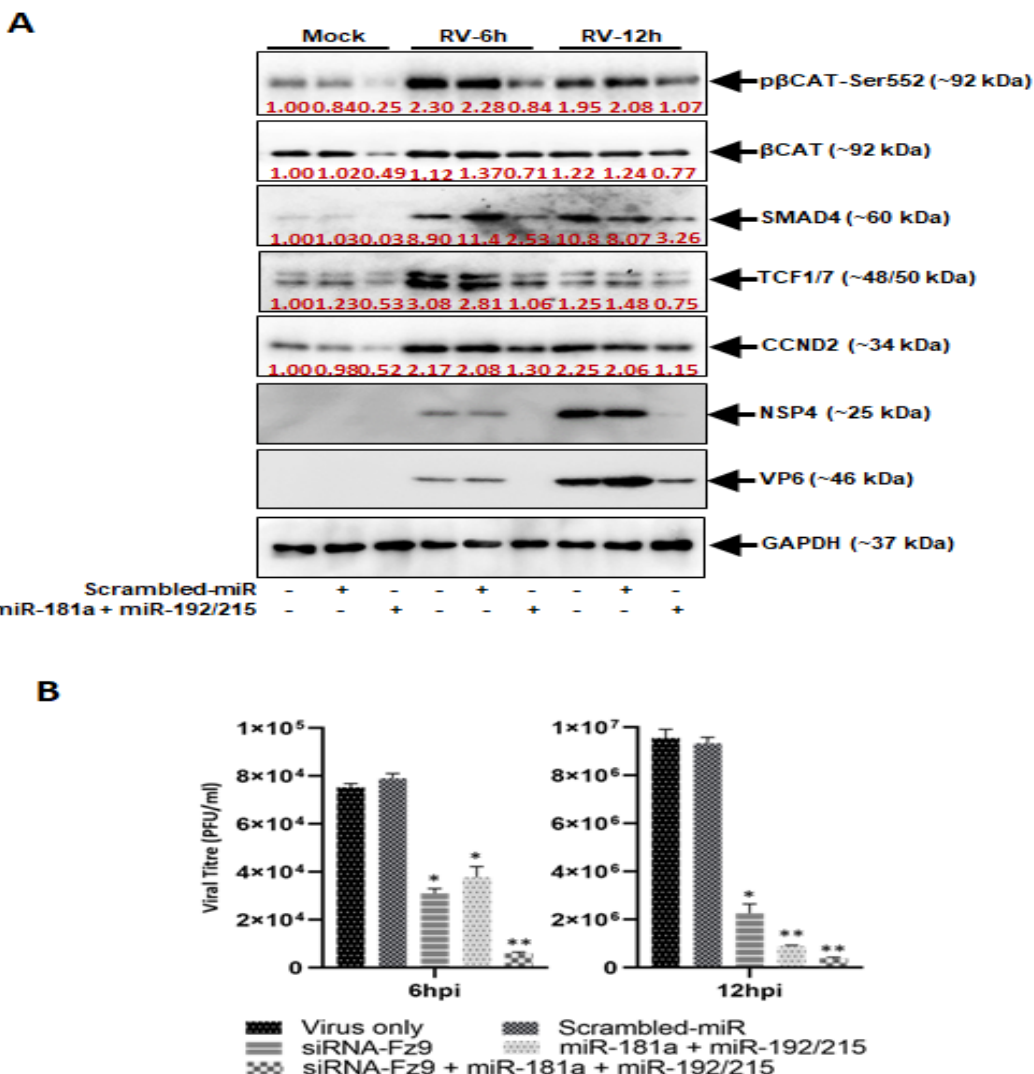
Figure 5. miR-181a and miR-192/215 inhibit RV replication. ( A ) Overexpression of miR-181a in presence of miR-192 andmiR-215 suppressed the phosphorylation of β -catenin in RV-infected MA104 cells. Expression of SMAD4, TCF1/7, and CCND2 is downregulated in presence of miR-192 family miRNA and miR-181a. Expression of RV structural protein VP6 and nonstructural protein NSP4 were also suppressed in presence of mimic miR-181a and miR-192/215; ( B ) Viral titer was measured at 6 hpi and 12 hpi in siRNA-Fz9 transfected and miR-181a and miR-192/215 overexpressed MA104 cells. RV replication was significantly suppressed in presence of either siRNA-Fz9 or mimic miR-181a and miR-192/215. The combined effect of siRNA-Fz9, miR-181a and miR-192 mimics creates much more significant anti-rotaviral state. * p < 0.05, ** p < 0.01.